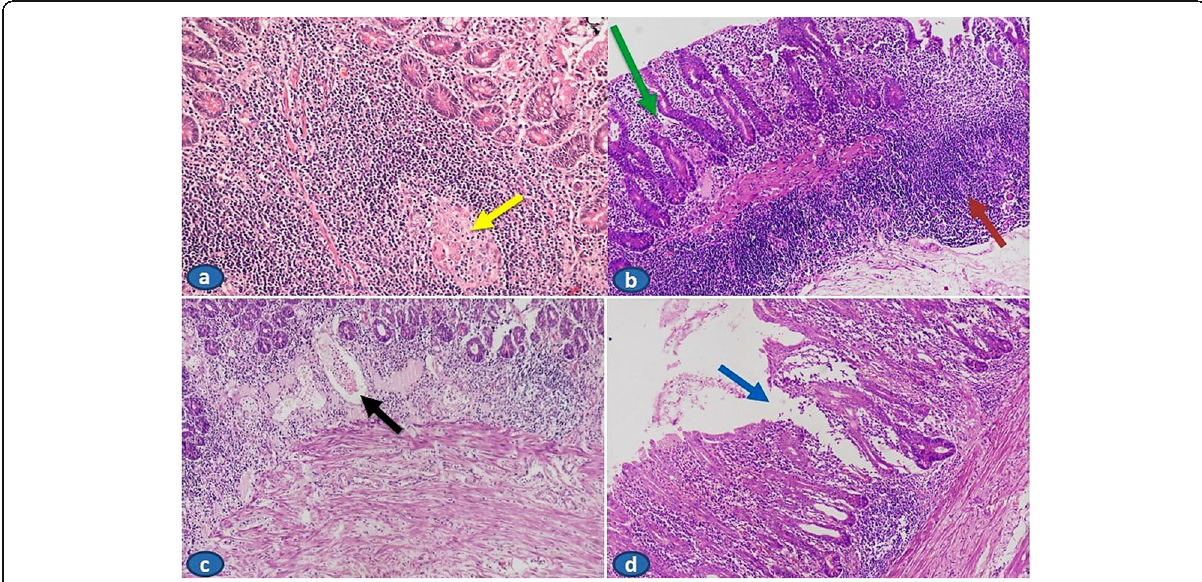
Fig. 3 Immunological changes. A Lymphoid hyperplasia with granulomatous reaction (yellow arrow). B Architectural change (green arrow) with prominence of lymphoid aggregates (orange arrow). C Dilated lacteals (black arrow). D Apthus ulcer (blue